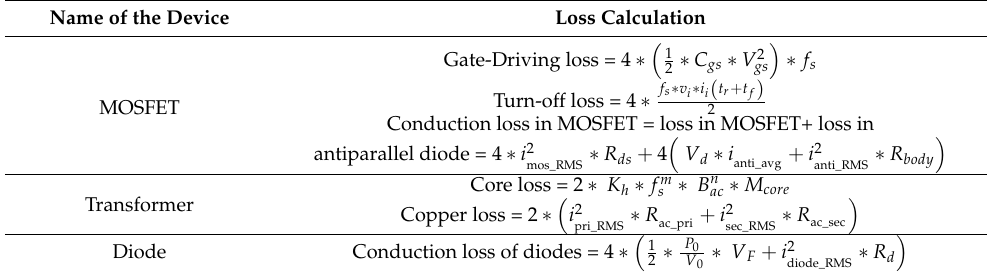
Table 3. Loss analysis for